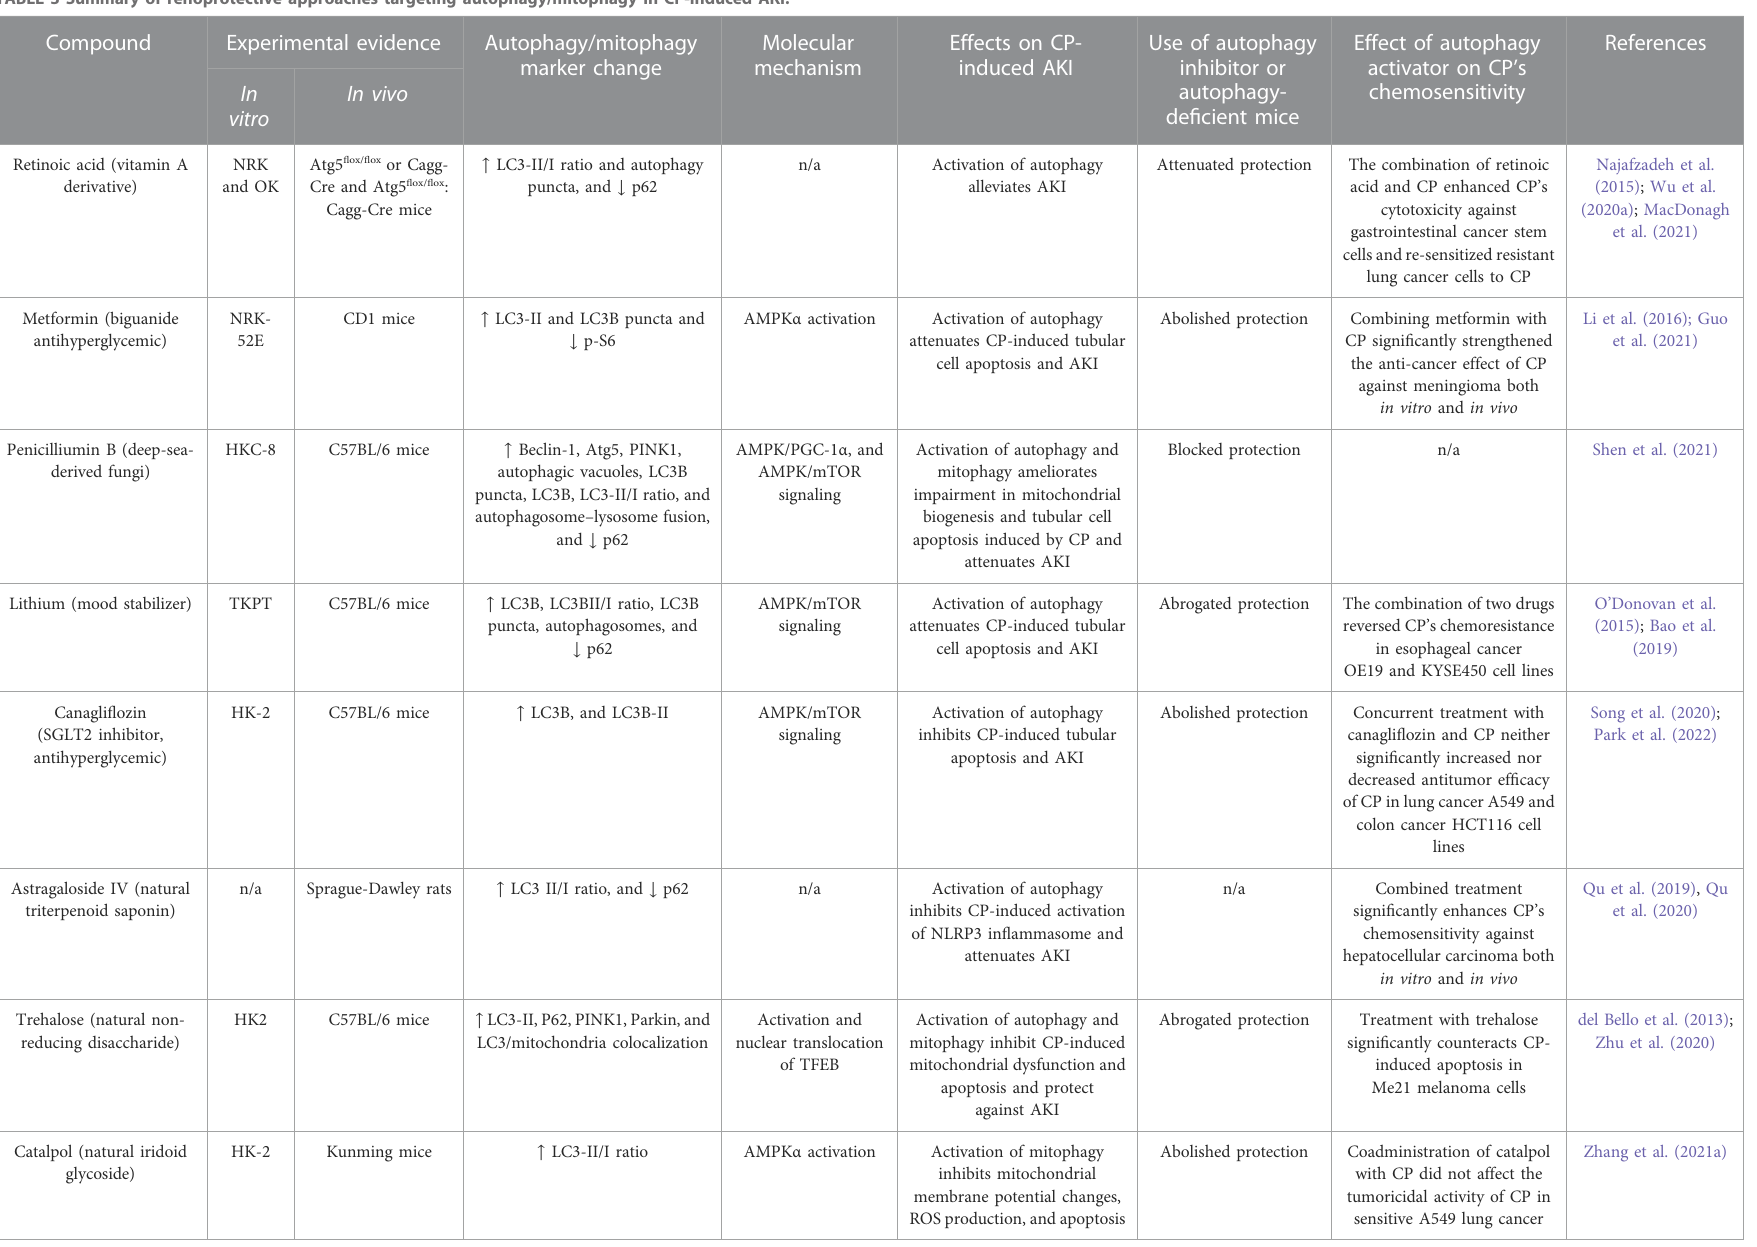
TABLE 3 Summary of renoprotective approaches targeting autophagy/mitophagy in CP-induced